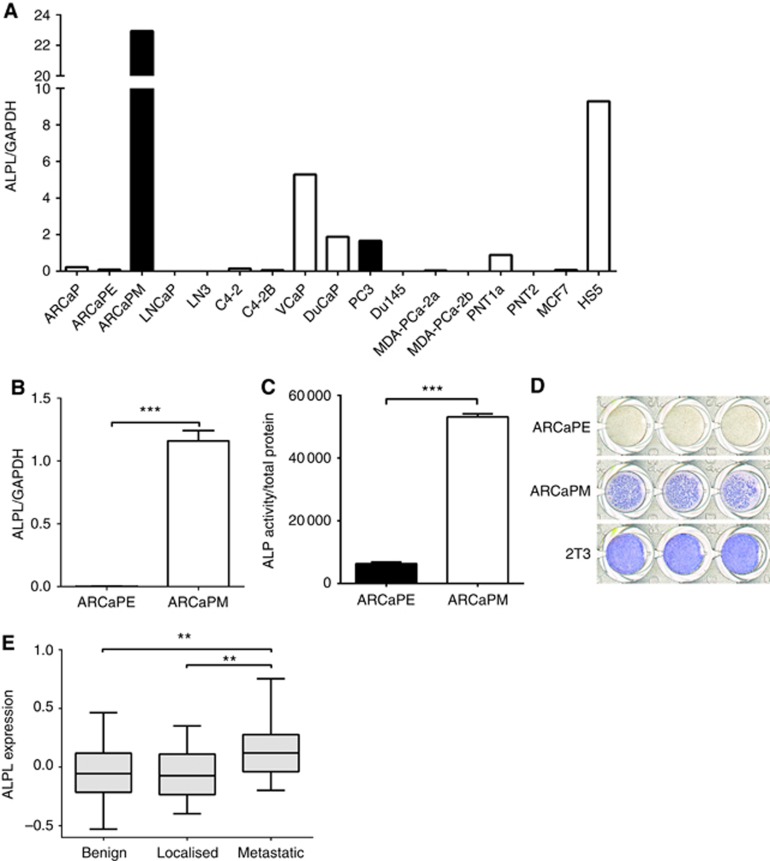
Alkaline phosphatase is expressed by prostate cancer cells and increased in metastatic prostate cancer. (A) ALPL mRNA expression (normalised with GAPDH (glyceraldehyde 3-phosphate dehydrogenase) expression) was measured using qRT–PCR in a panel of prostate cancer cell lines, the breast cancer cell line MCF7 and the bone marrow stromal cell line HS5. Bars for metastatic cell lines (ARCaPM, C4-2B and PC3) are shaded in black. (B) ALPL mRNA expression (normalised with GAPDH expression) was measured using qRT–PCR and (C) alkaline phosphatase activity (normalised with total protein) was measured using a quantitative fluorimetric assay, in ARCaPE and ARCaPM cells. (D) ARCaPE, ARCaPM and 2T3 cells were stained for alkaline phosphatase activity. (E) The Tomlins et al. data set (Tomlins et al, 2007) was analysed for ALPL mRNA expression in benign prostatic hyperplasia, localised prostate cancer and metastatic prostate cancer samples. (**P<0.01, ***P<0.001).